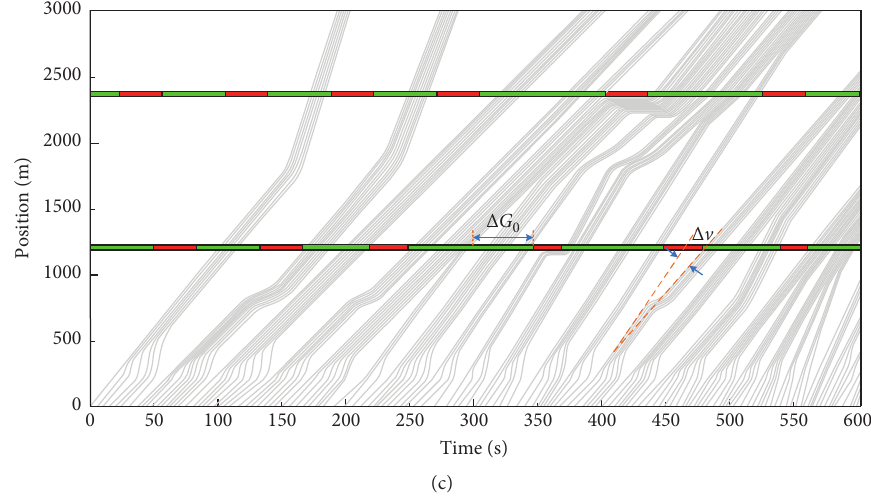
Figure 5: Vehicle space-time trajectory: (a) FC method; (b) FC-SG method; (c) FC-SG-SO